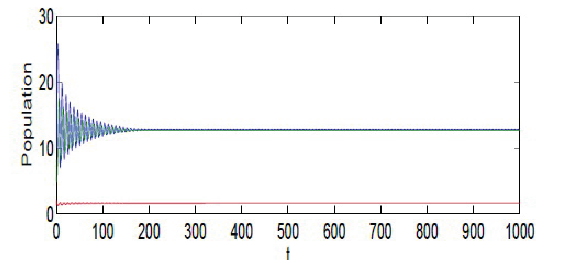
Fig. 2: All trajectories converges to R * in the absence of delay i.e. at τ = 0